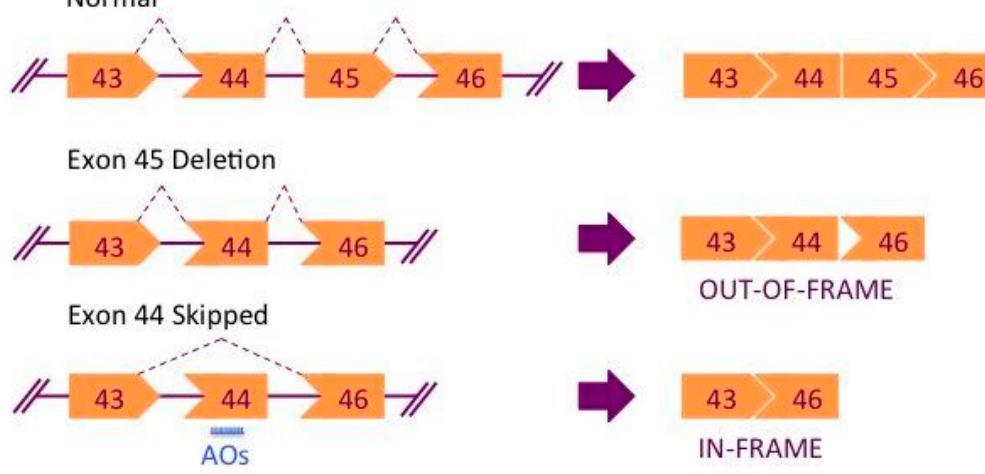
Figure 1. Mechanism of exon skipping therapy for Duchenne muscular dystrophy (DMD). Deletion of exon 45 results in a frameshift in the spliced mRNA. Treatment with AOs can correct the reading frame producing a truncated yet partly functional protein, as in the case of Becker muscular dystrophy (BMD).